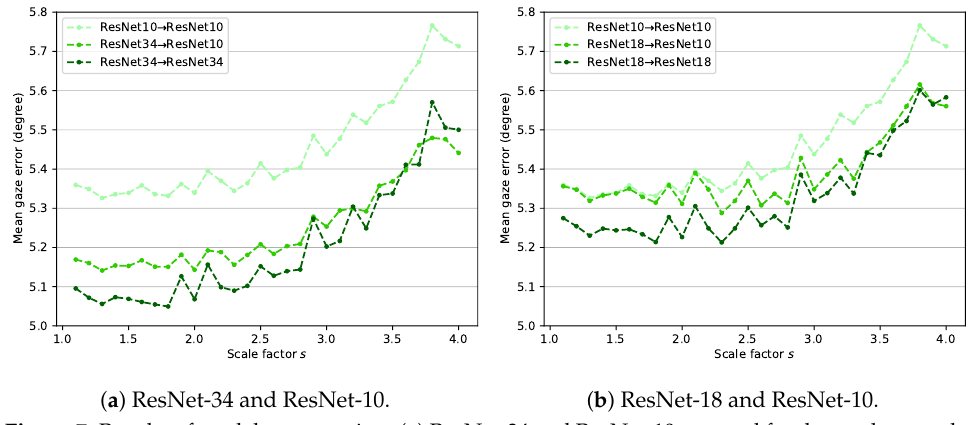
Figure 7. Results of model compression. ( a ) ResNet-34 and ResNet-10 are used for the teacher–student framework. ( b ) ResNet-18 and ResNet-10 are used for the teacher–student framework.